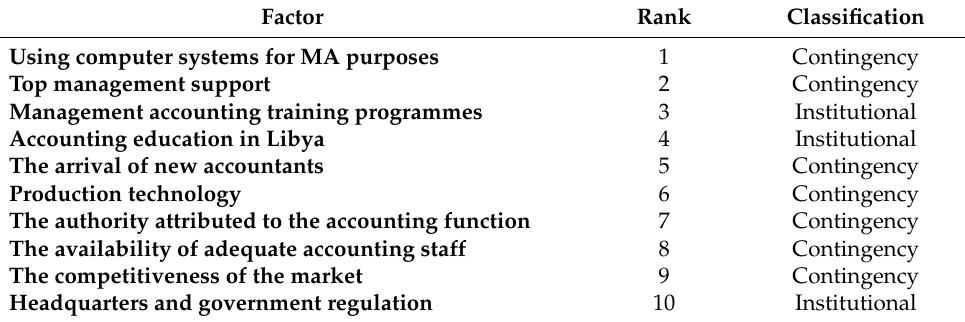
Table 16. The top ten factors that may facilitate the adoption of MAIs in the manufacturing sector. Factor Rank Classification